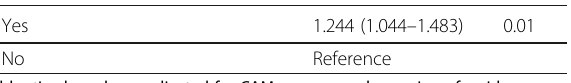
Table 3 Factors associated with satisfaction after complementary and alternative medicine (CAM) use by children ( n =1,365) (Continued)